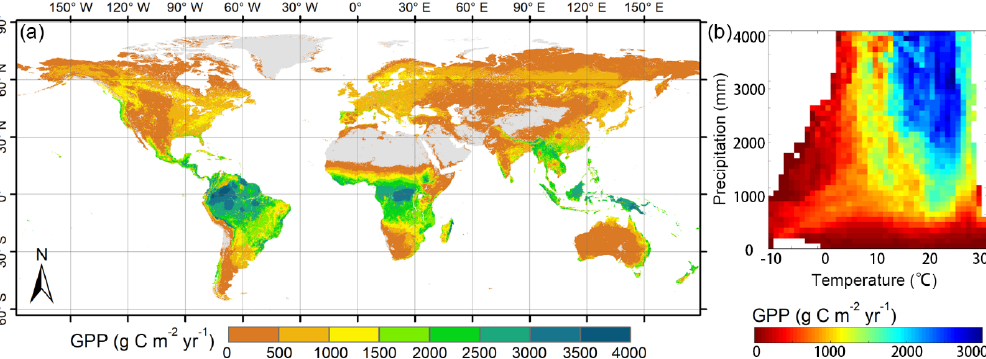
Figure 5. Spatial pattern of global GPP simulated by the revised EC-LUE model during 1982–2017: (a) averaged annual GPP; (b) averaged annual GPP at different temperature and precipitation